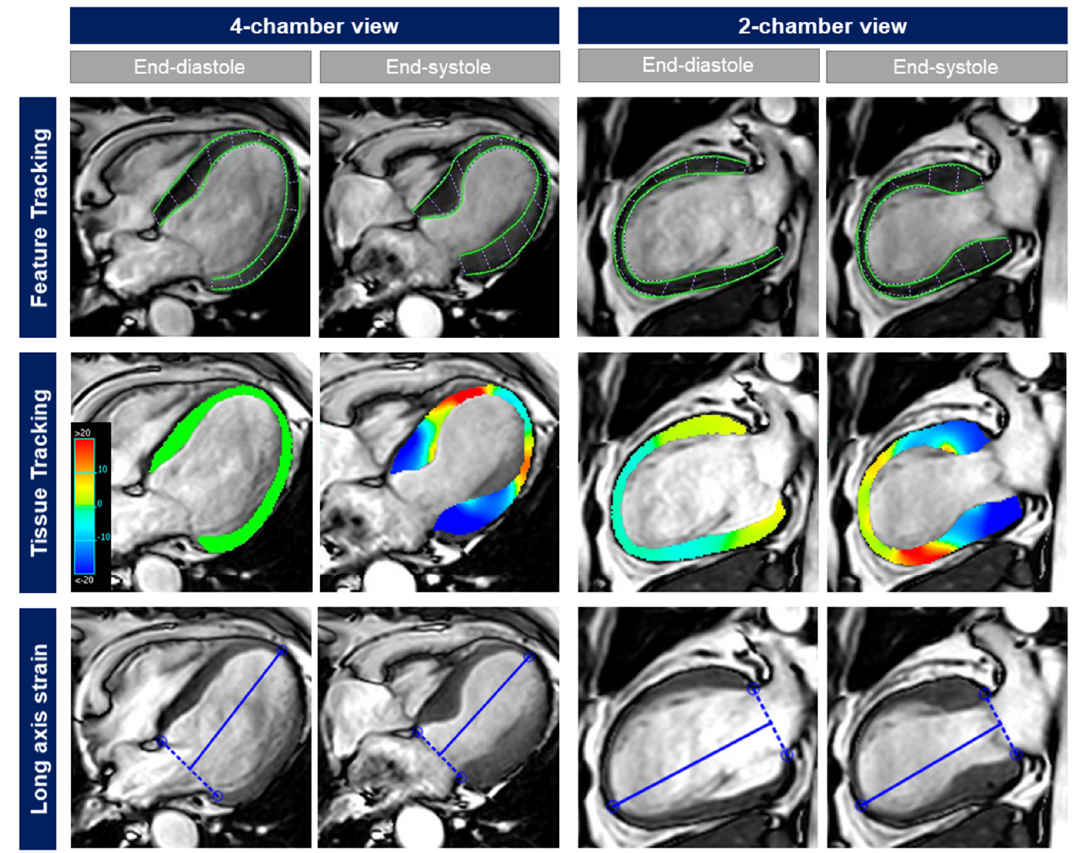
Figure 1. Different CMR-based approaches for the assessment of LV longitudinal strain in a 68-year old female patient presenting with TS and typical apical ballooning. While LV ejection fraction was only moderately reduced (42%), FT-GLS ( − 7.9%), TT-GLS ( − 8.1%), and fast manual LAS ( − 9.6%) showed a severely impaired longitudinal strain.